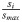
Airport vulnerability and nodal infection probability versus normalized node strength.The scatter plot of the vulnerability ϕ (points) and infection probability v (lines) of a node versus the normalized node strength sismax of the node on the underlying network topology G1. The black dashed line corresponds to the baseline homogeneous model (θ = 0). Solid lines correspond to the heterogeneous model with θ = 1.50, colored according to the parameter c (figure a) or with c = 0.02, colored according to the parameter θ (figure b).